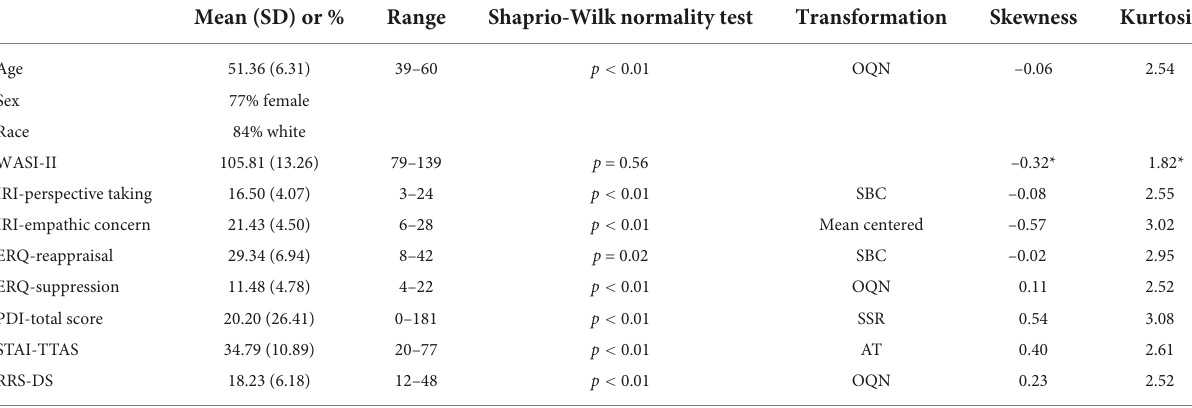
TABLE 1 Sample characteristics and normality assessment of key